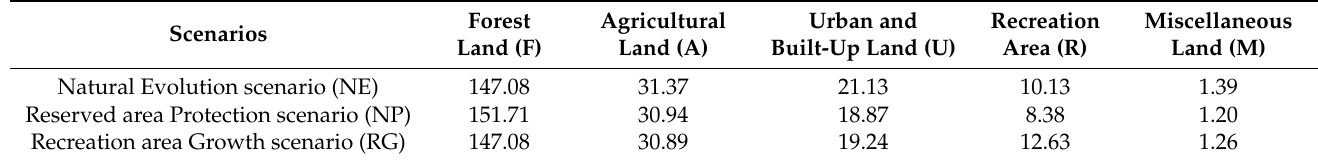
Table 6. The land-use demand in three scenarios of Koh Chang in 2050 (km 2